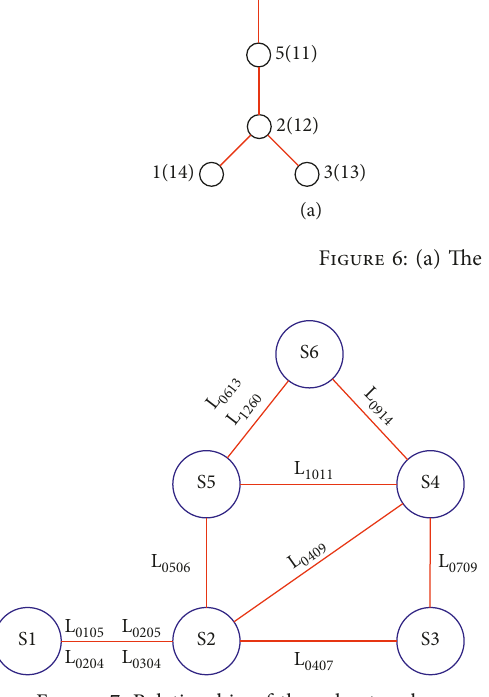
Figure 7: Relationship of the